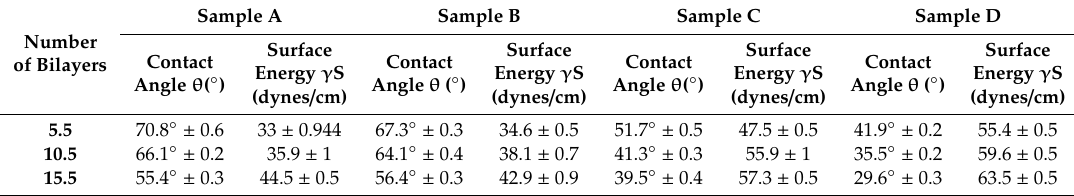
Figure 12. ( a ) Contact angle of bilayers of fabricated thin film gradients versus various pH combinations of MPC / PAA and ( b ) Surface energy versus the number of bilayers of samples (A, B, C and D) fabricated at various pH. Table 3. Contact angles and surface energy of 5.5, 10.5, 15.5 bilayers of samples A, B, C and D fabricated at various pH